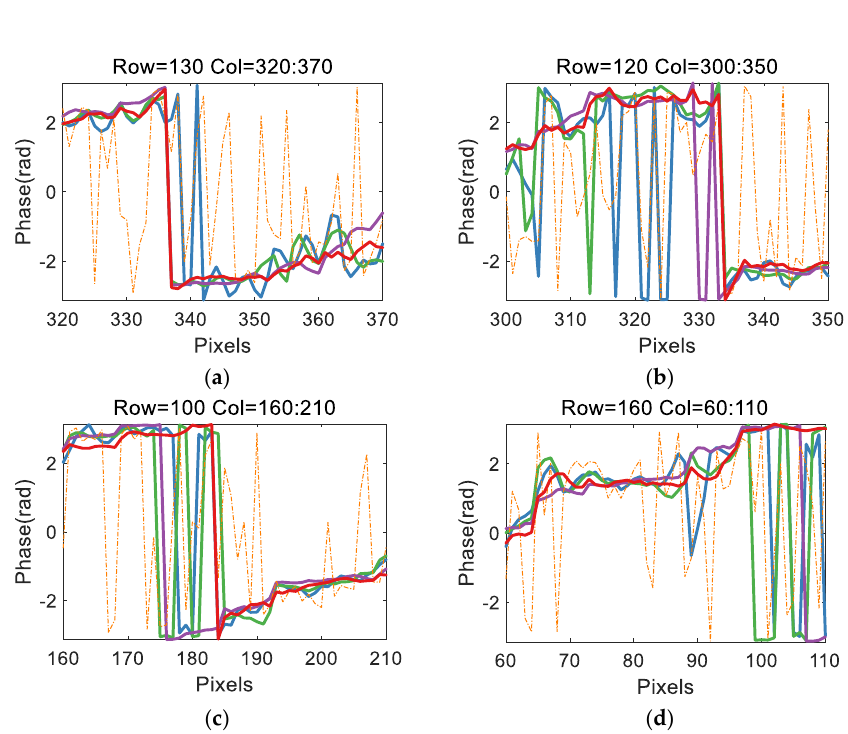
Figure 16. The filtered phase profiles with OLCP-InSAR (red line) and other reference filtered methods based on tensor decomposition. ( a ) The filtered phase profiles at row 130 and column 320 to 370. ( b ) The filtered phase profiles at row 120 and column 300 to 350. ( c ) The filtered phase profiles at row 100 and column 160 to 210. ( d ) The filtered phase profiles at row 160 and column 60 to 110.